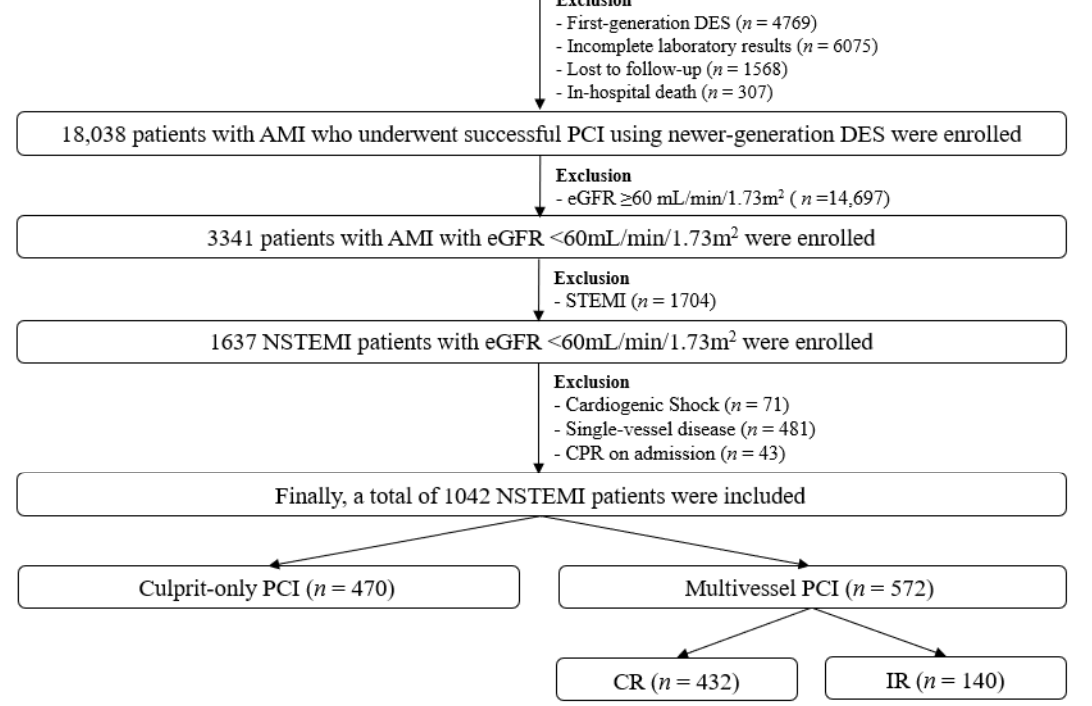
Figure 1. Flowchart. AMI, acute myocardial infarction; PCI, percutaneous coronary intervention; DES, drug-eluting stent; KAMIR, Korea AMI Registry; eGFR, estimated glomerular filtration rate; STEMI, ST-segment-elevation myocardial infarction; NSTEMI, non-STEMI; CPR, cardiopulmonary resuscitation; CR, complete revascularization; IR, incomplete revascularization.